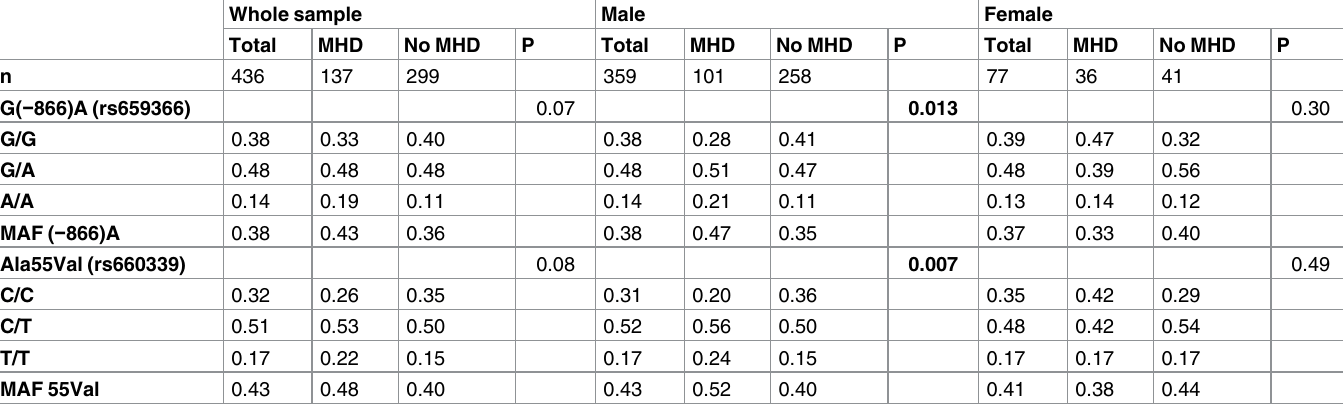
Table 1. Comparisons of allelic distributions across the whole sample and between participants with and without mental health disorders. Whole